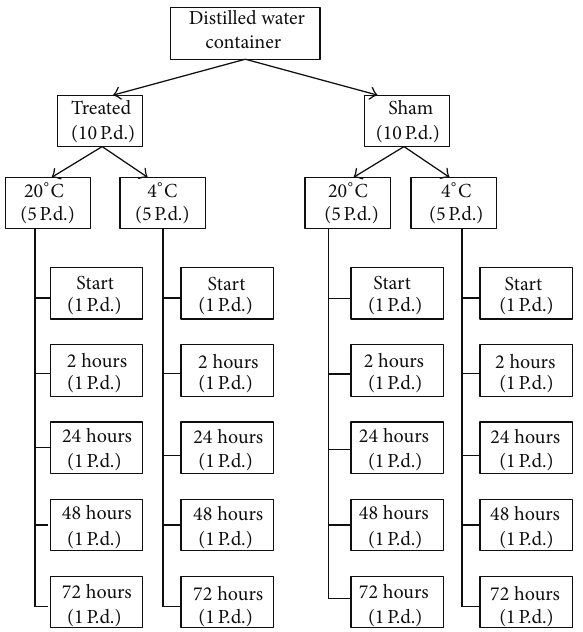
Figure 1: Protocol of experiments of the study of Sham and NIR treated DW effects on seed hydration at the end of 2, 24, 48, and 72 hours of incubation in